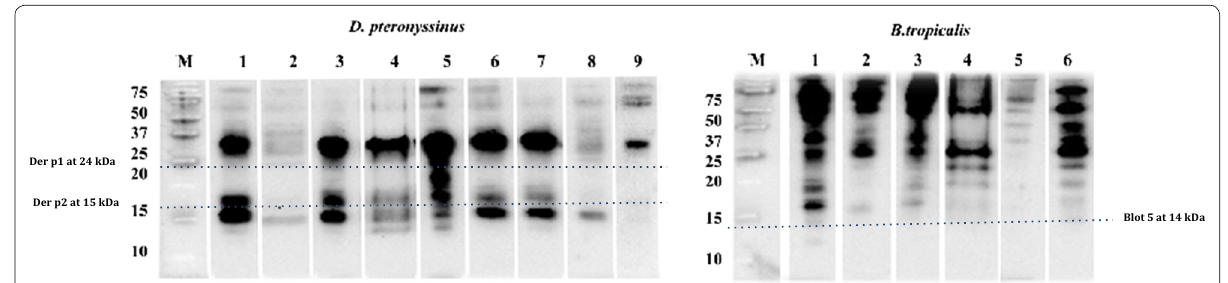
Fig. 2 IgE Immunoblotting of commercial extracts ( D. pteronyssinus and B.tropicalis ) from manufacturers 1 to